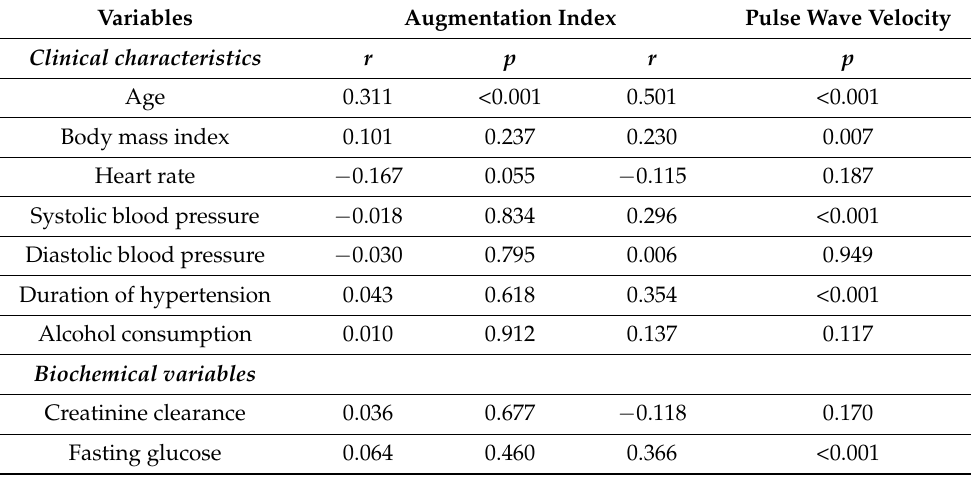
Table 2. Univariate analysis of the relationships between the augmentation index and pulse wave velocity and study variables.